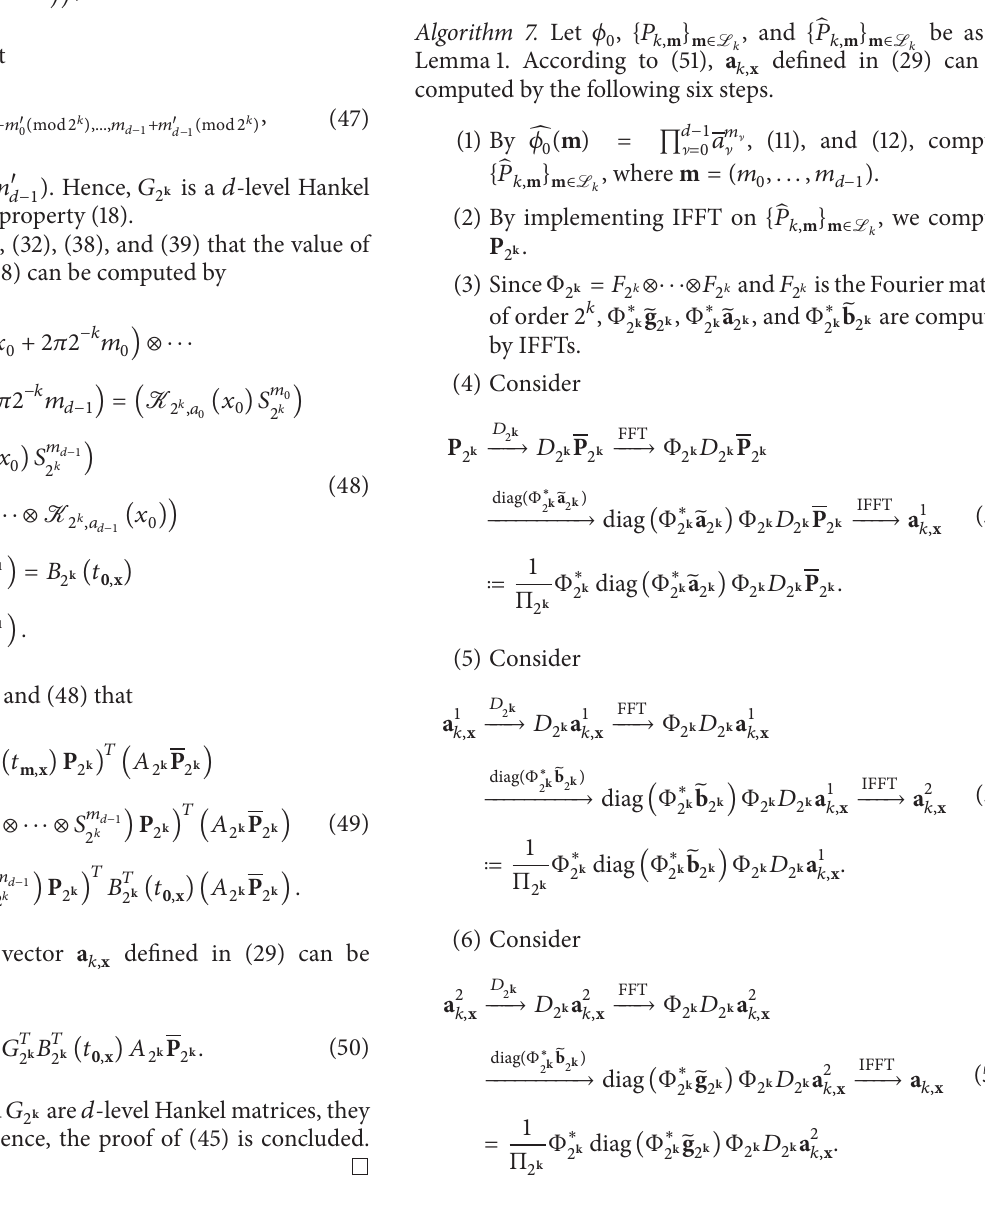
Algorithm 7. Let 𝜙 0 , {𝑃 𝑘, m } m ∈ L